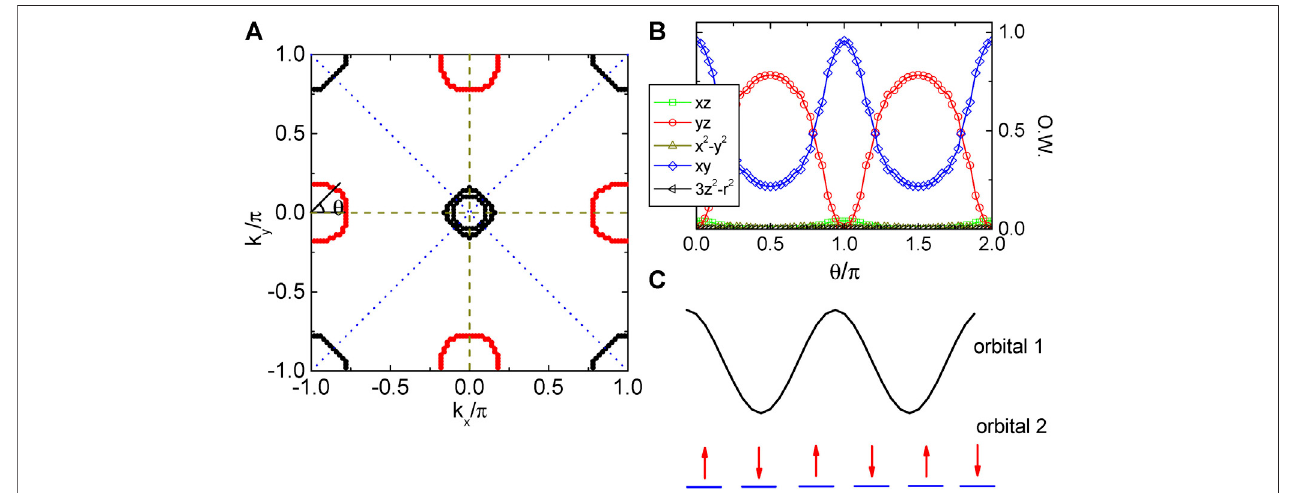
FIGURE 1 | (A) : Fermi surface of a fi ve-orbital multiorbital Hubbard model for the iron pnictides, consisting of both hole (black symbols) and electron (red symbols) pockets.The1-FeBrillouinzone(BZ)isusedhereafter. (B) Orbitalweights(O.W.)alongtheelectronpocketcenteredat ( π , 0 ) . θ isde fi nedinpanel (A) ,adaptedfrom[72]. (C) Sketch ofthe orbital-selective Mott phase in a two-orbitalmodel. Orbital 1 ismetallic, with its renormalized bandwidth being nonzero, and orbital 2is aMott insulator where the active degree of freedom is a magnetic moment localized at each site. Note that interorbital coupling is in general nonzero in the kinetic part of the Hamiltonian. The OSMP can develop only when the corresponding interorbital coupling is renormalized to zero.